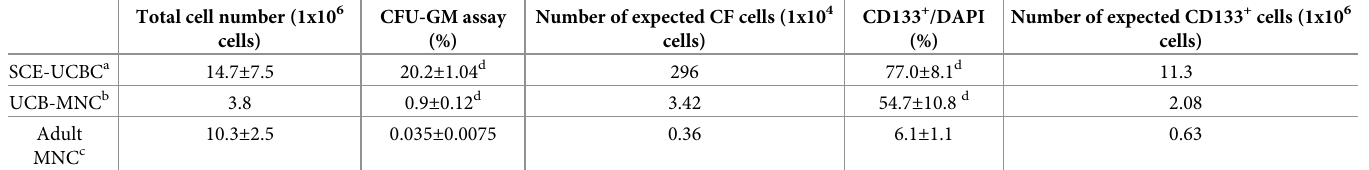
Table 4. The number of cells examined.